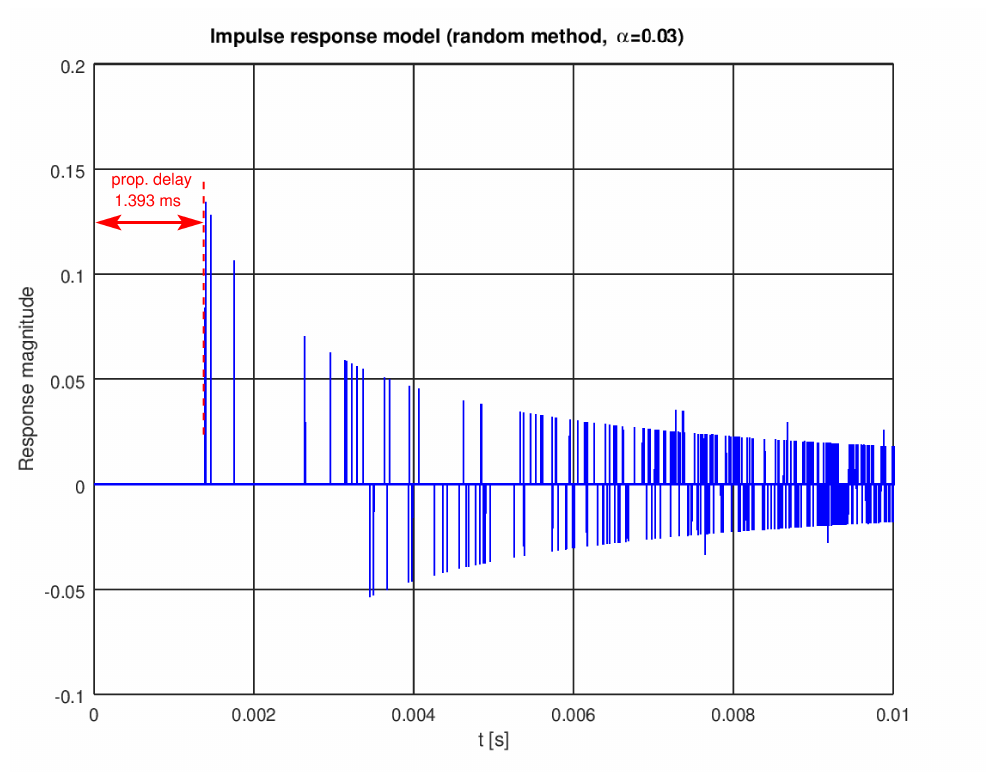
Figure 5. Zoomed initial part of Figure 4 (impulse response with the random modeling).